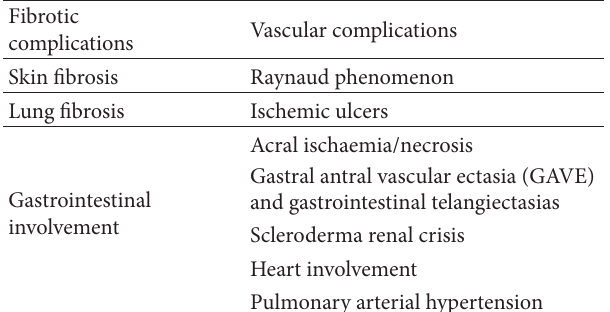
Table 1: Most prominent fibrotic and vascular complications of SSc.